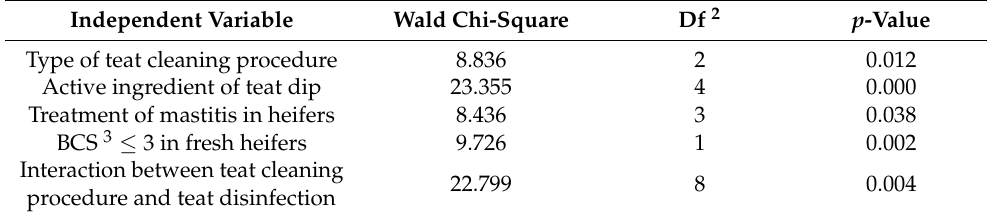
Table 6. Independent variables significantly associated with HMR 1 —tests of model effects.